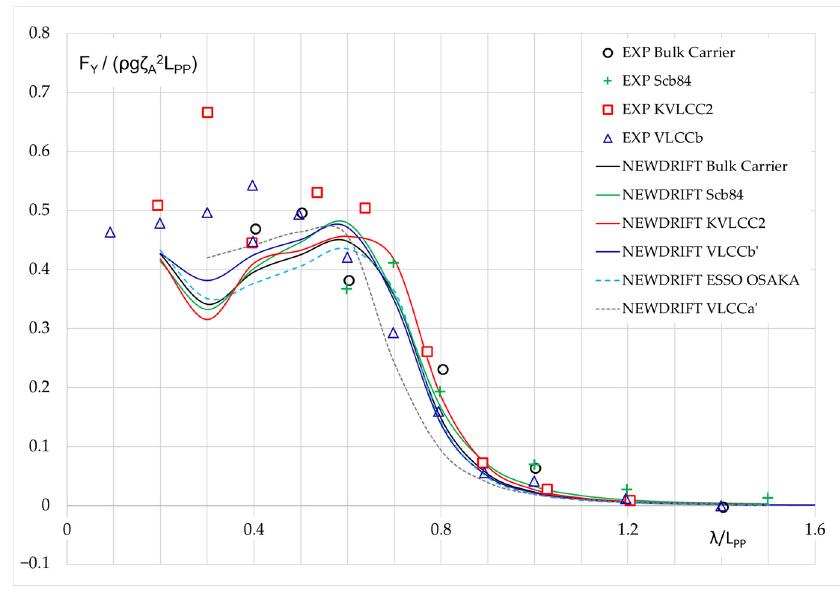
Figure 2. Mean sway force of six ships in regular beam waves at zero speed.